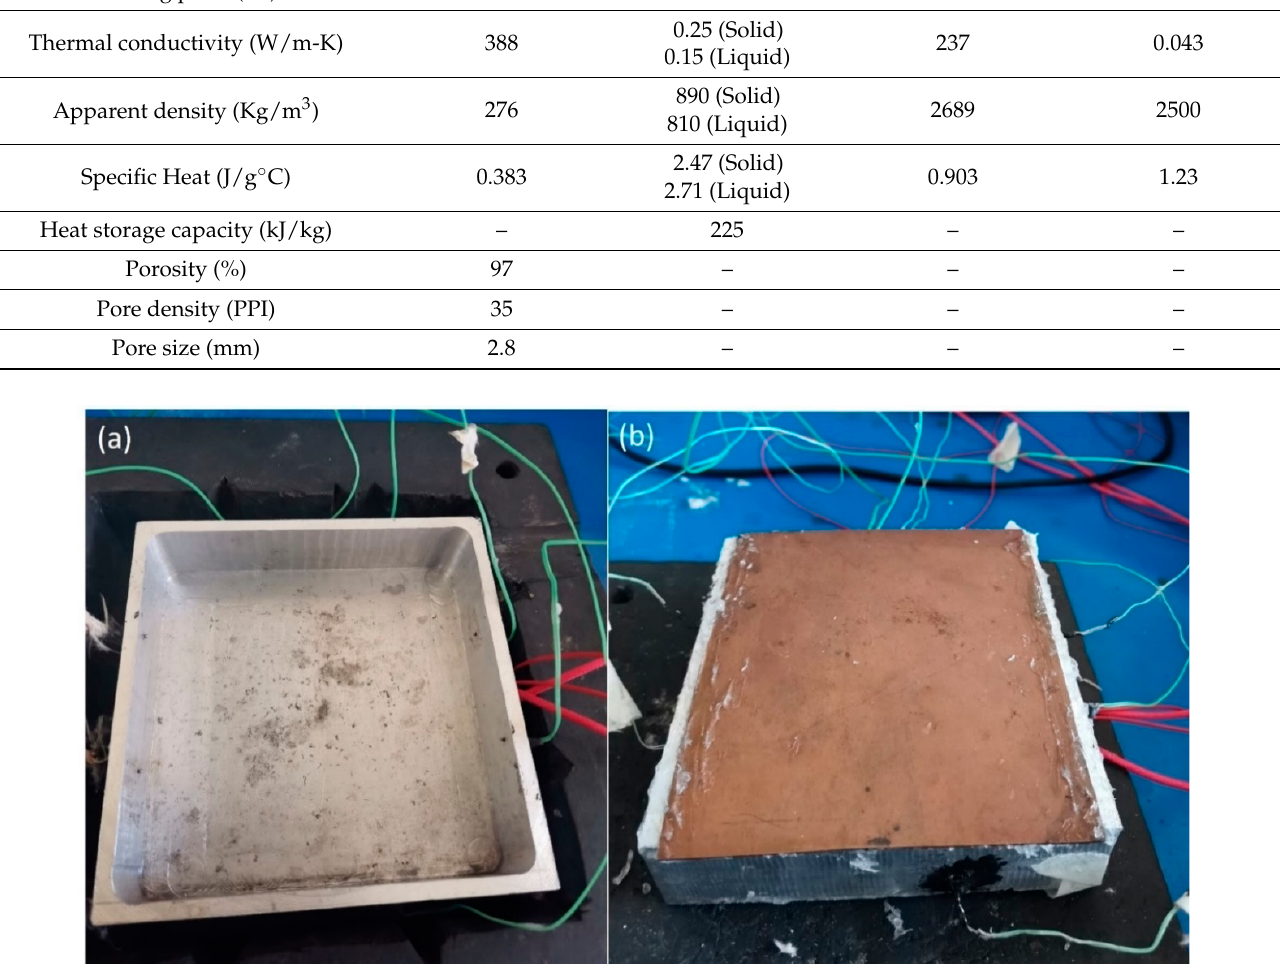
Table 2. Nanoparticles Properties [23,24,27].